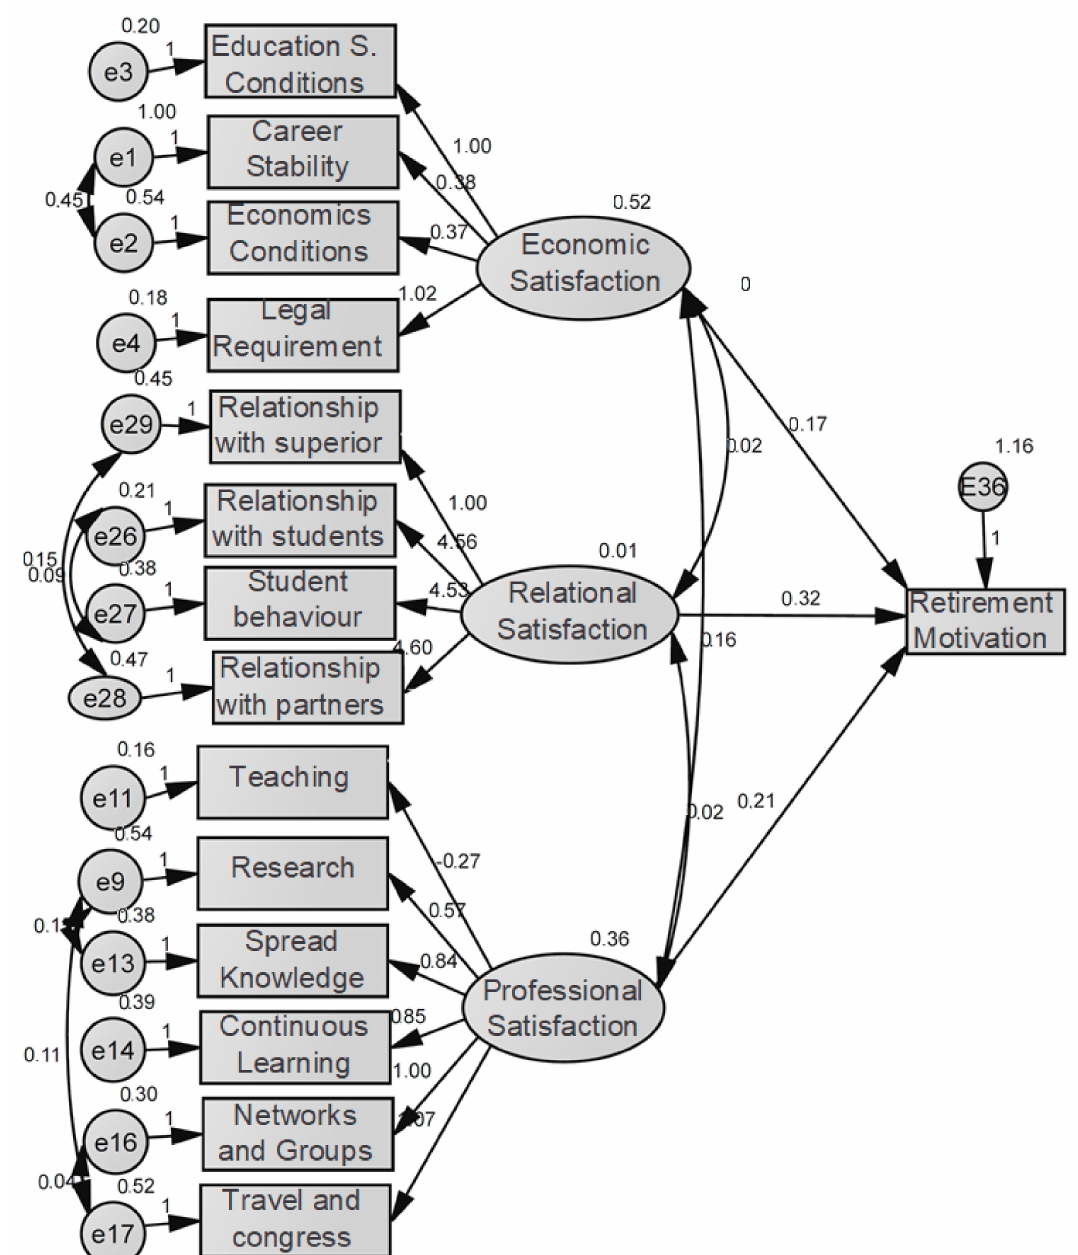
Figure 3. Model 1 path diagram: Influence of economic, relational, and professional satisfaction in the overall